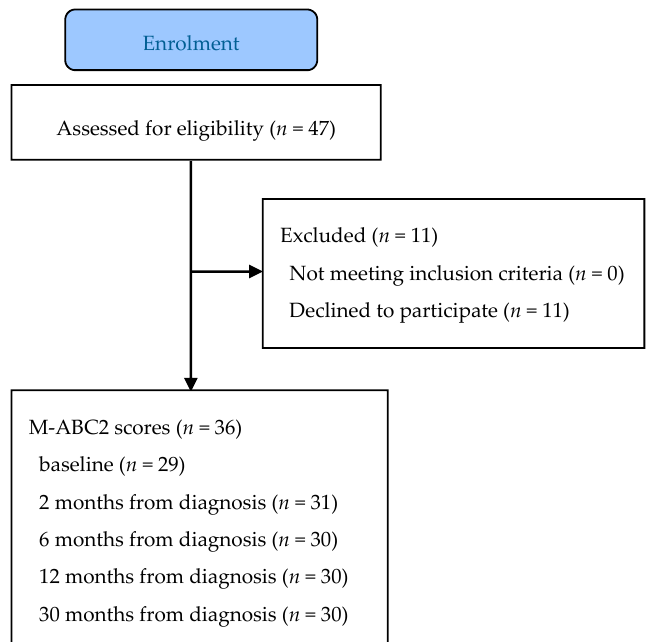
Figure 1. Flow chart of participants.